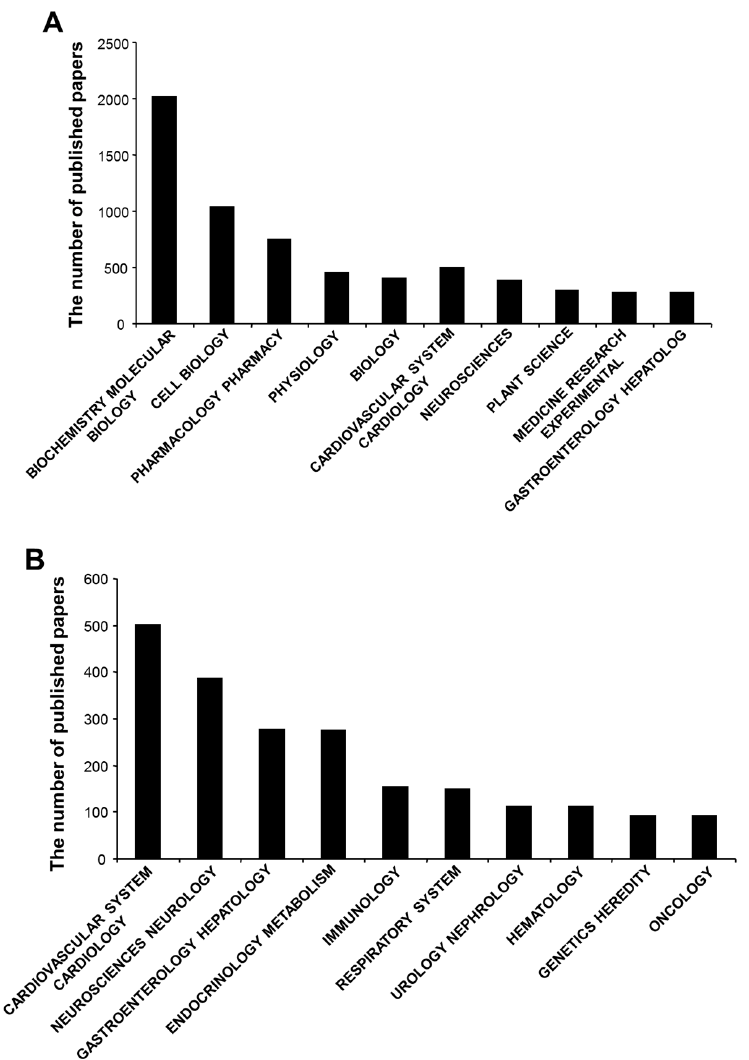
Figure 5. The mostly studied disciplines in H 2 SBM research. ( A ) the top 10 hottest disciplines in H 2 SBM research; ( B ) The top 10 hottest topics in H 2 S medicine research.